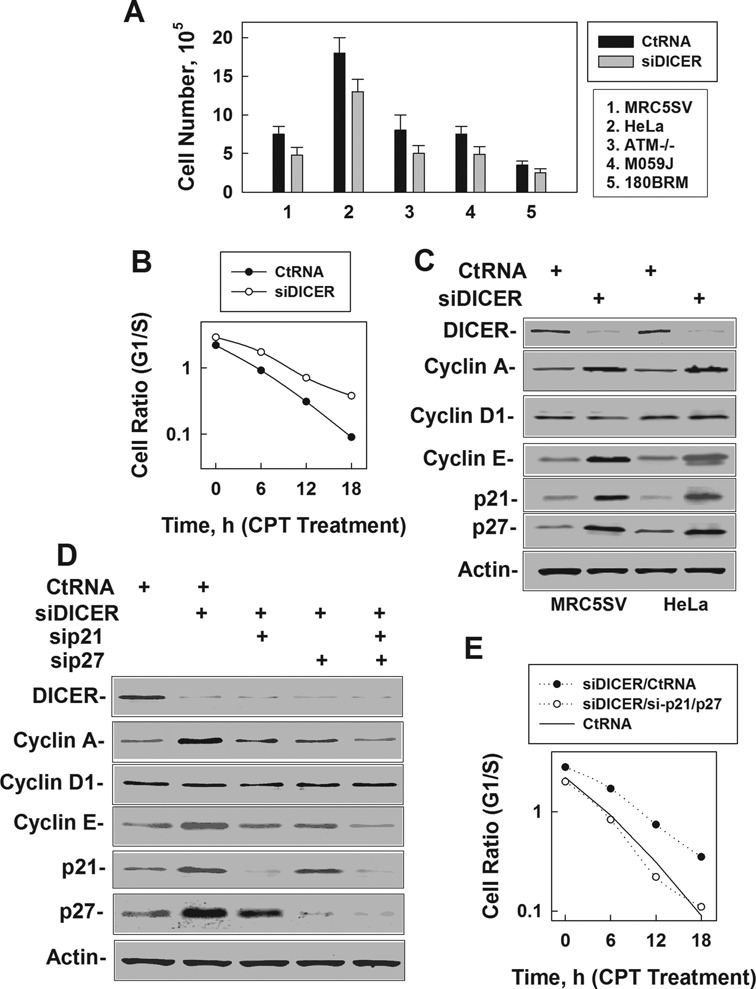
Knockdown of DICER prolongs the G1/S transition through up-regulating p21Waf1/Cip1 and p27/Kip1. (A) The number of human cells (MRC5SV, HeLa, ATM−/−, M059J and 180BRM) was counted at 72 h after the cells were treated with CtRNA or siDICER. The data were obtained from two independent experiments. (B) HeLa cells were collected at 60 h after treatment with CtRNA or siDICER. HeLa cells in the G1 and S phases were detected by combining dye from PI, BrdU labeling and flow cytometry as described in the Supplementary Materials. Similar results were obtained from three independent experiments that the authors carried out. (C) Immunoblot detection was performed from MRC5SV and HeLa cells treated with siDICER for 60 h. Similar data were obtained from two independent experiments that the authors carried out. (D) HeLa cells were treated with siDICER with or without siRNA against p21 or/and p27 (si-p21, si-p27 or si-p21/si-p27) for 60 h, and the cells were collected for immunoblot detection. Similar data were obtained from two independent experiments. (E) The effects of si-p21/si-p27 on the G1-S transition in the DICER knockdowns. HeLa cells were collected for detecting G1 and S phase cell distribution as described in B. Similar results were obtained from three independent experiments that the authors carried out.